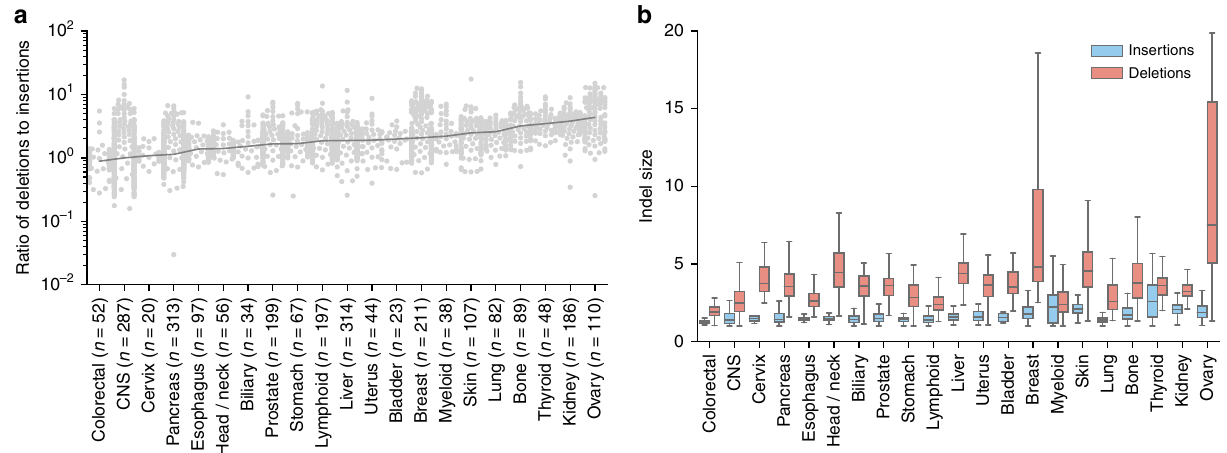
Fig. 1 Indel characteristics across cancer types. a The ratio of deletions to insertions for each tumour type. (Mann – Whitney U test, p value < 0.05 per cancer type). b Distribution of the size of insertions and of deletions for each tumour type. Deletions displayed greater size variance in comparison to insertions across cancer types (Levene ’ s test, p value < 0.05) and for individual cancer types ( p value < 0.001 in breast, pancreas, liver, ovary, skin, lung, cervix, bone, head/neck, colorectal, p value < 0.05 in biliary and lymphoid